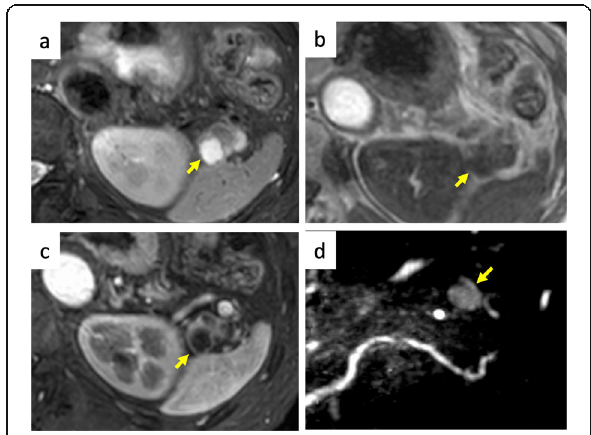
Fig. 4 Macroscopic appearance and histological examination of the resected specimen. a Macroscopic appearance. Accessory spleen (yellow arrow) and multiple cystic lesions containing organized mucinous (white arrow) in the pancreatic tail. b A loupe image of the left side specimen in Fig. 4a. Pancreatic tissue (yellow arrow) and accessory spleen (white arrow) were detected on the upper side and the right side of the lesion, respectively. Inset: islets of Langerhans and pancreatic ducts were seen on the lower side of the lesion. c Accessory spleen consisted of red pulp (yellow arrow) and white pulp (white arrow) and was located between the cysts